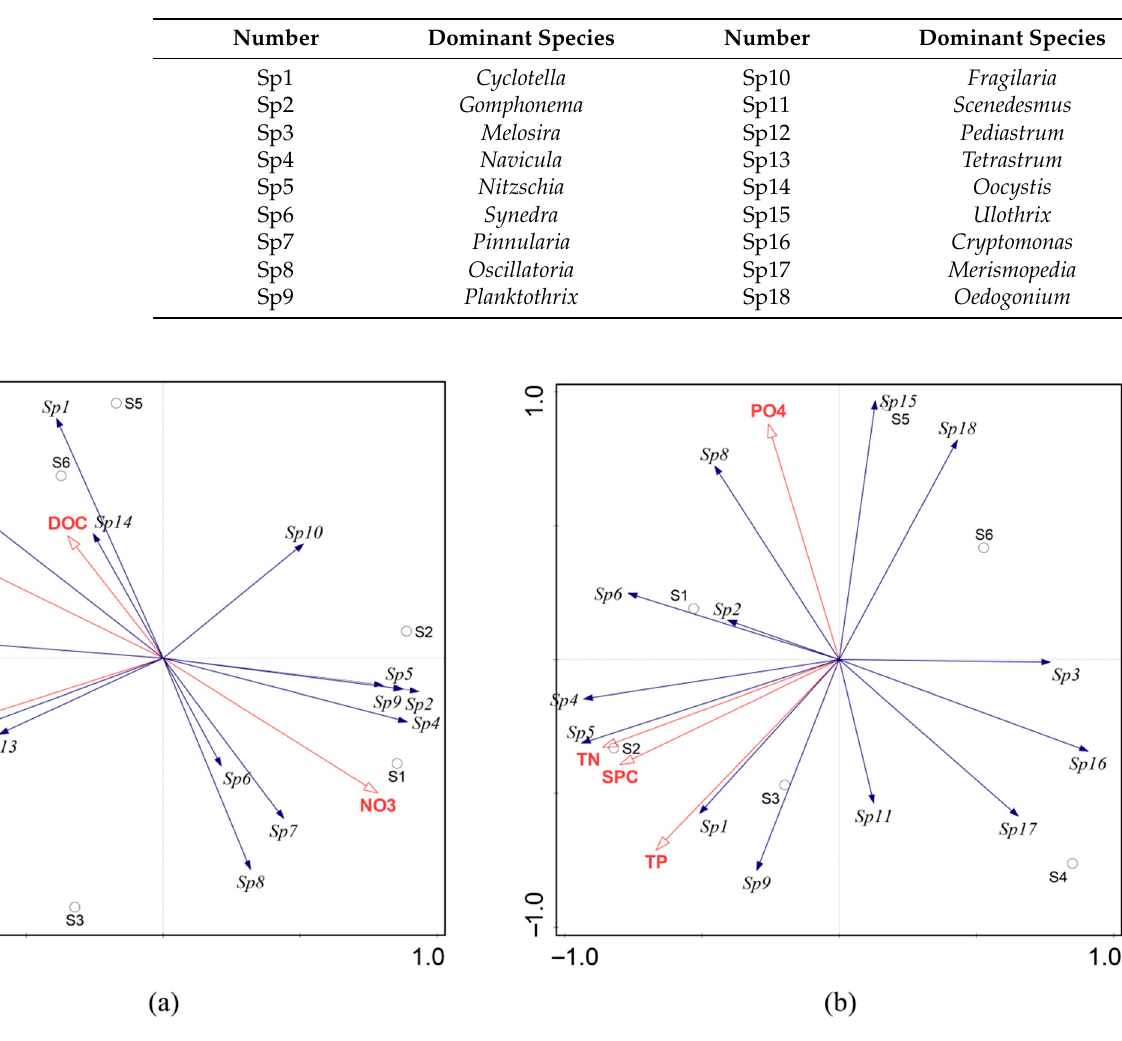
Table 2. Species and numbers of periphytic algal communities in the RDA ranking map.